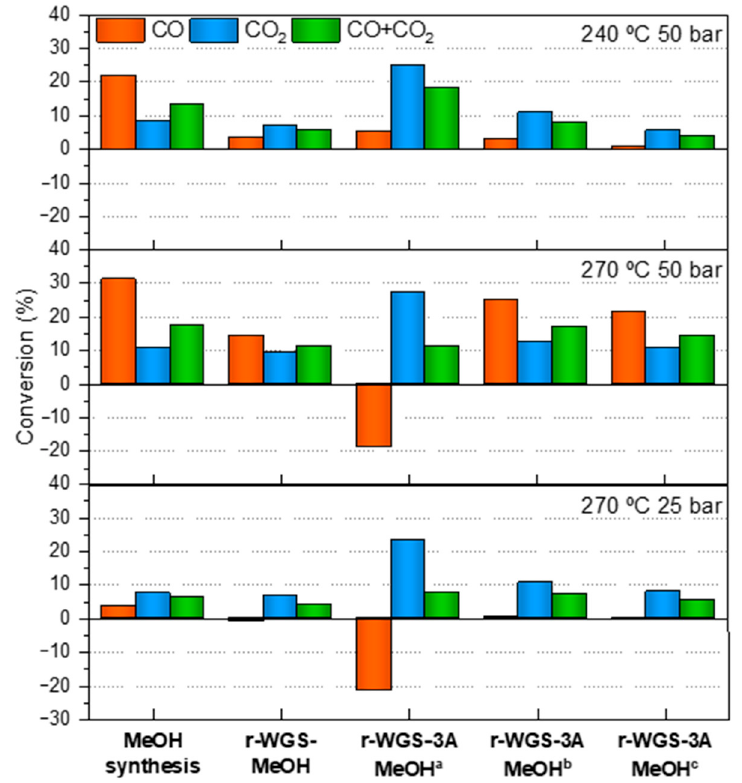
Figure 5. CO, CO 2 and CO + CO 2 conversions obtained with the single-step methanol synthesis reactor (MeOH synthesis), the double bed of r-WGS and methanol synthesis reactor (r-WGS-MeOH) and the combined bed of r-WGS, water sorption and methanol synthesis (r-WGS-3A-MeOH). a First collected data set of the experiment (TOS near to 0). b Value at TOS near to 2, within the dynamic state. c Value after the stationary state was reached (saturation of the sorbent).